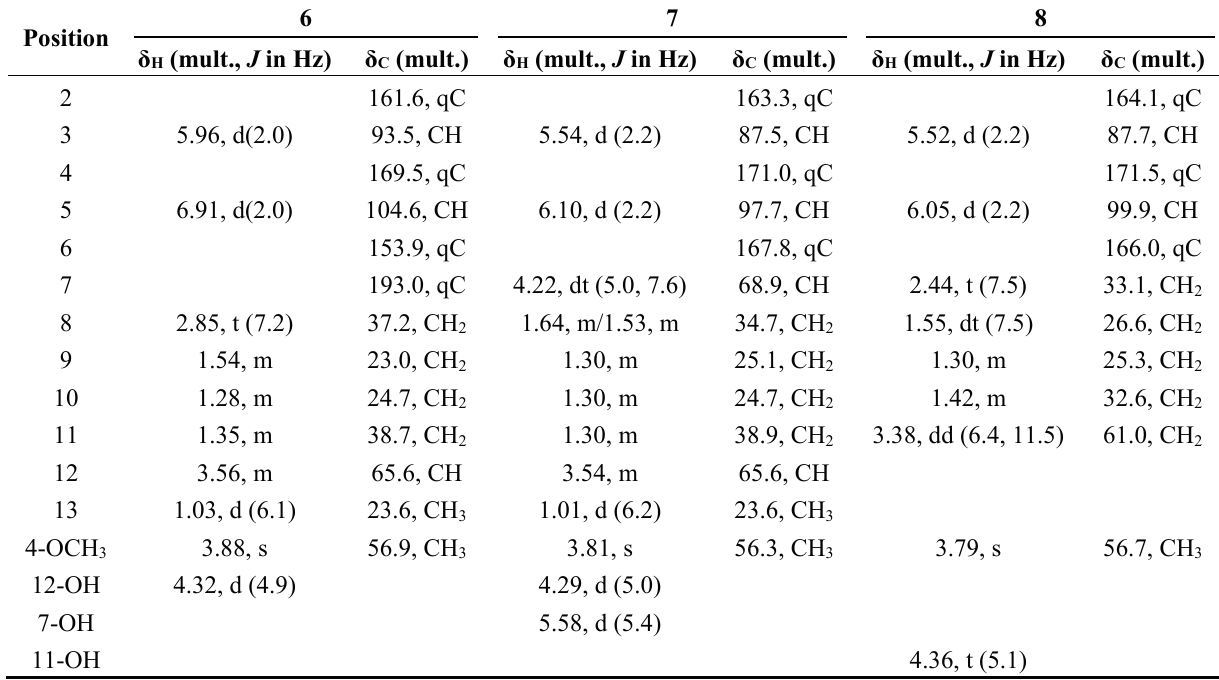
Table 1. 1 H- and 13 C-NMR spectral data (400 MHz, DMSO) of compounds 6 – 8